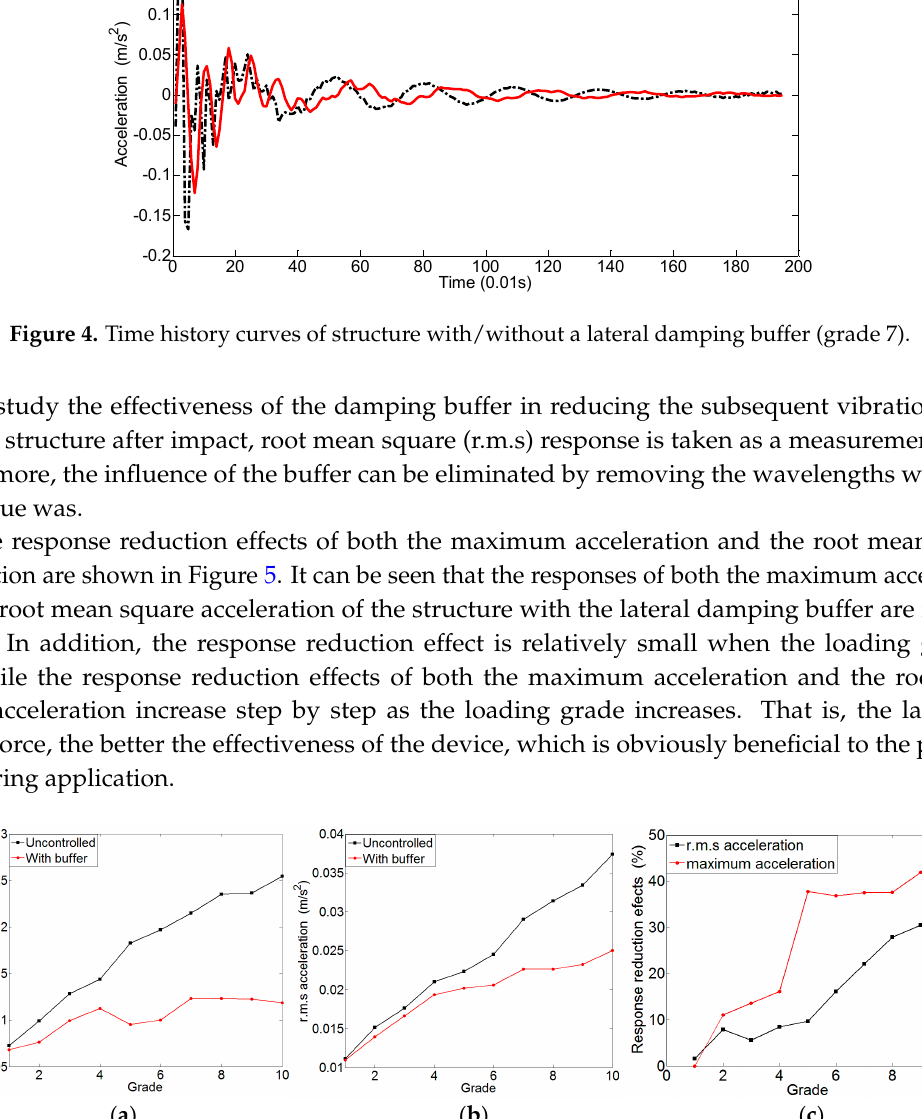
Figure 5. Acceleration response and the reduction efficiency: ( a ) Maximum acceleration; ( b ) Root mean square (r.m.s) acceleration; ( c ) Response reduction effects.